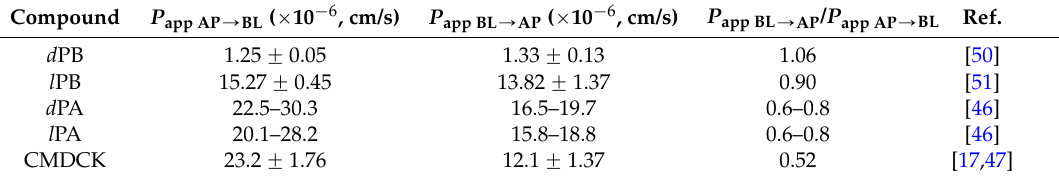
Table 2. The bi-directional P app values of some khellactone derivatives in the Caco-2 cell monolayer